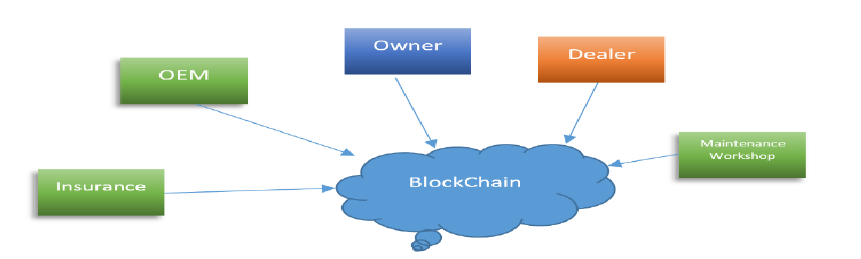
Figure 5. BCVehis [30].